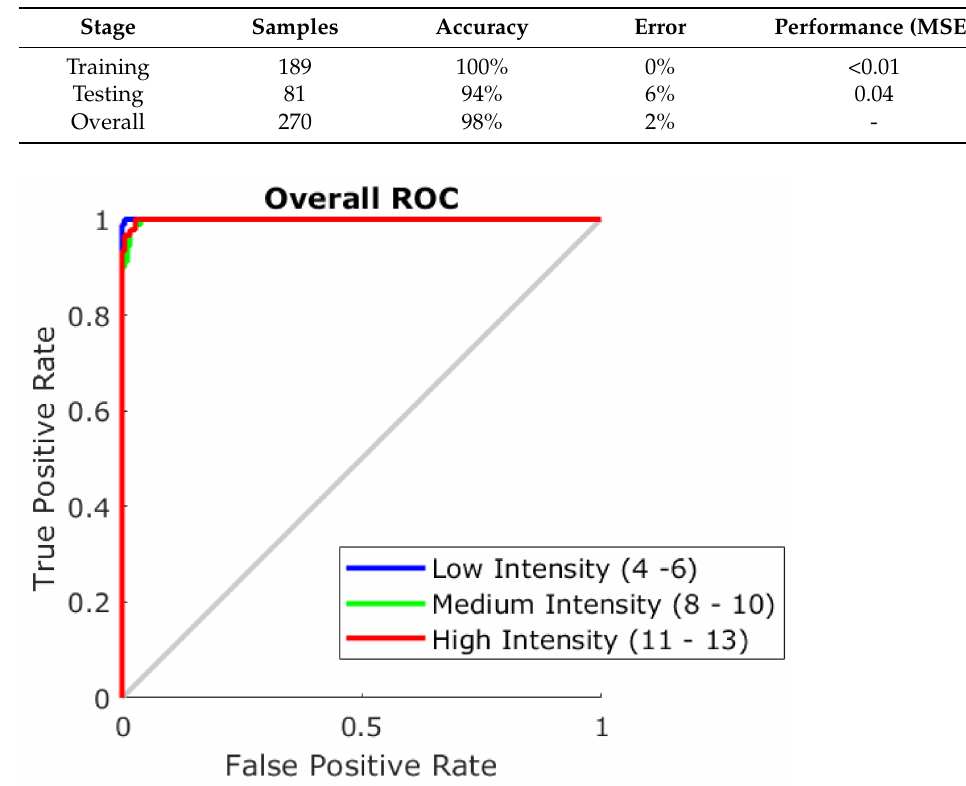
Figure 6. Overall receiver operating characteristics (ROC) curve showing the true positive (sensitivity; y-axis) and false-positive (specificity; x-axis) rates of the classification Model 1.